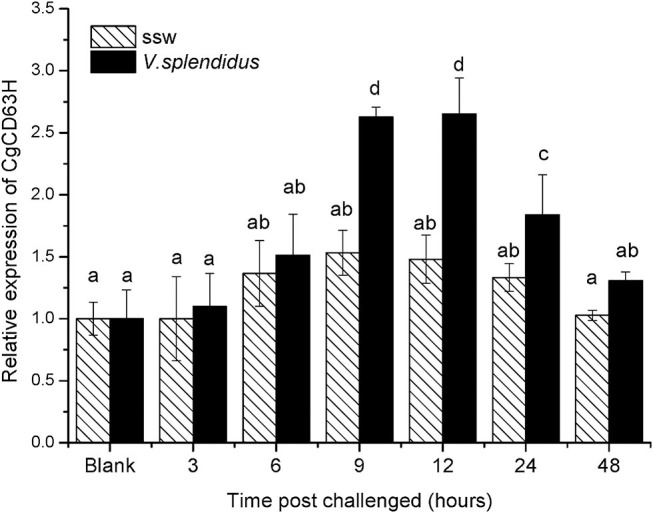
Temporal expression profile of CgCD63H messenger RNA (mRNA) post-V. splendidus challenge. Oyster hemocytes were employed to analyze CgCD63H expression, at 0, 3, 6, 12, 24, and 48 h after V. splendidus challenge. Comparison of the level of CgCD63H mRNA (relative to CgEF1-α) was normalized to 0 h, which was indicated as “relative expression level of CgCD63H.” The values were shown as mean ± SE (n = 6), and bars with different letters were significantly different (p < 0.01).